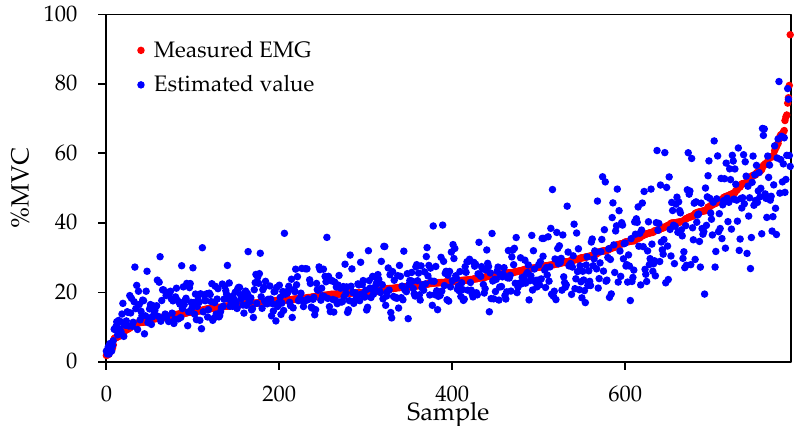
Figure 11. Plots of measured EMG and estimated value of the pectoralis in subject 1.